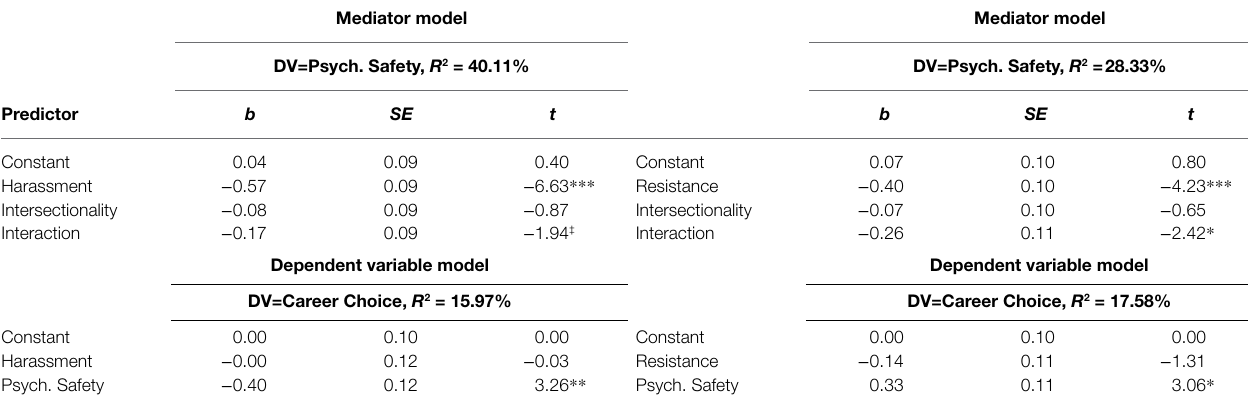
TABLE 4 | Moderated mediation results for harassment (left panel) and resistance (right panel). Mediator model Mediator